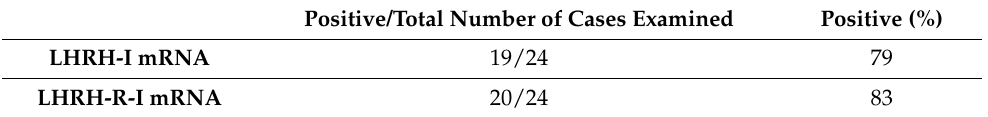
Table 1. Expression pattern of mRNA for LHRH-I and LHRH-R-I in human bladder cancer specimens. Positive/Total Number of Cases Examined